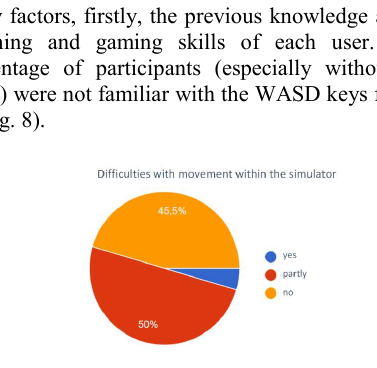
Figure 8: Movement/ navigation evaluation within the